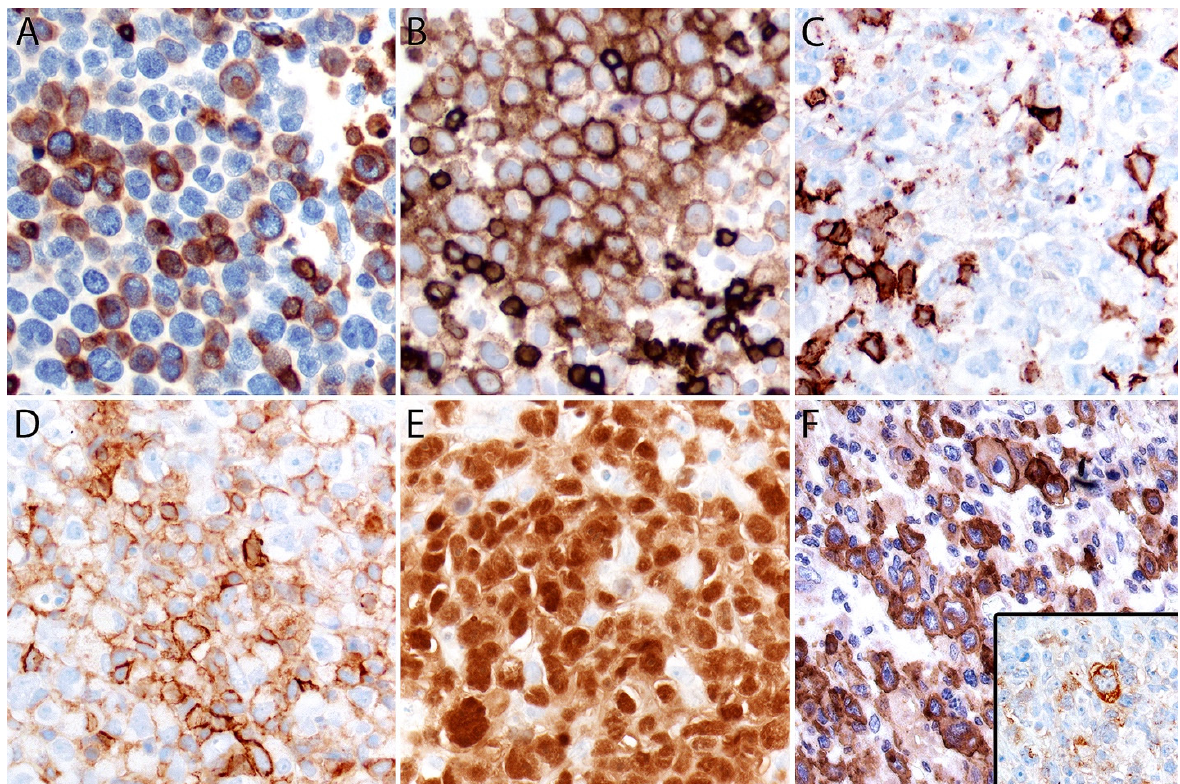
Figure 5. Immunohistochemistry in systemic ALK- ALCL. ( A ) Variable expression of CD3. ( B ) Positive CD5. ( C ) CD8 is negative in the large lymphoma cells and positive in background cytotoxic T-cells. ( D ) Variable CD45. ( E ) Strong MUM1 expression. ( F ) EMA is positive in ~40% of cases. Rare cases can express ≥ 1 cytokeratin ( F , inset) that along with a positive EMA could be misinterpreted as carcinoma if ALCL is not considered in the differential diagnosis.